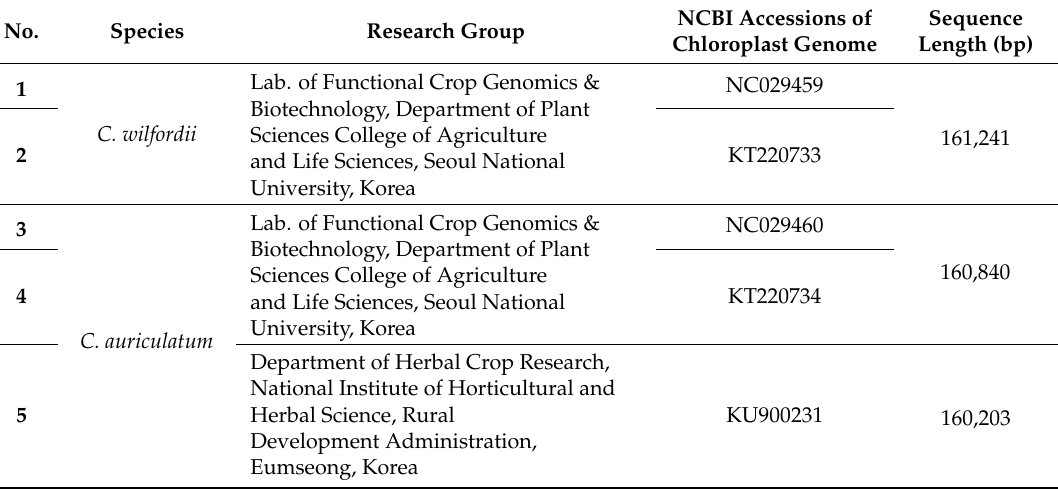
Table 3. Chloroplast sequences of C. wilfordii and C. auriculatum used in this study No. Species Research